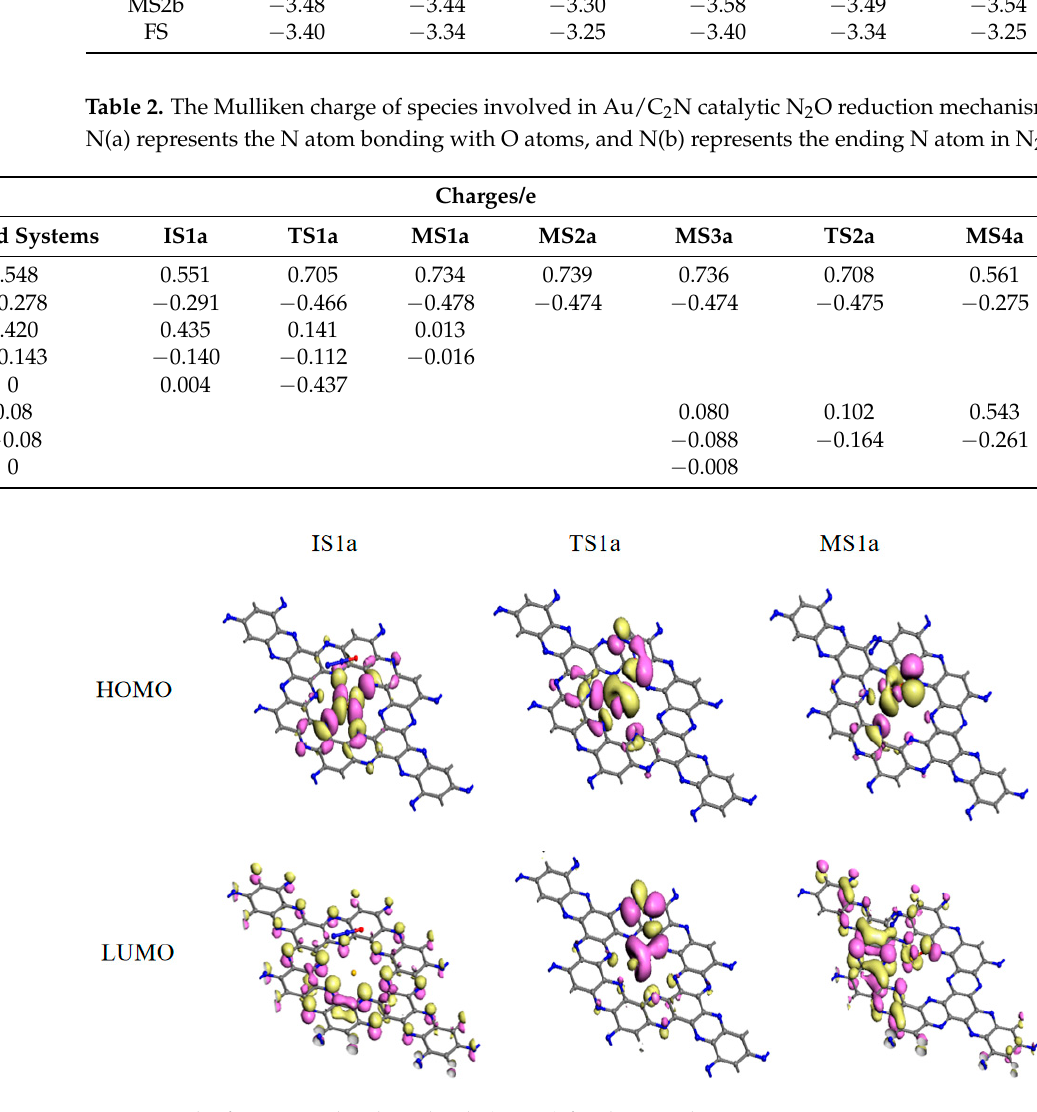
Figure 4. The frontier molecular orbitals (FMOs) for the rate-determining step IS1a → TS1a → MS1a in the N 2 O reduction mechanism I on Au/C 2 N. (The isovalue is setting is default, 0.03 a.u.) .